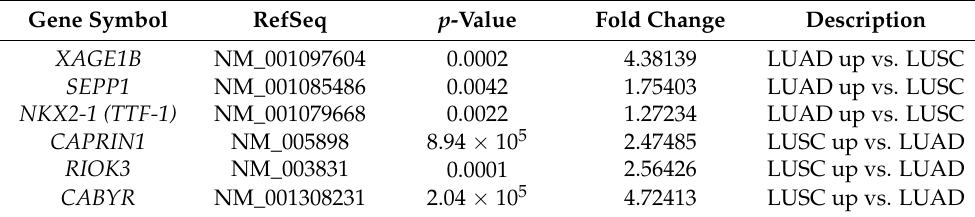
Table 1. Main DEGs for each histology screened using Clariom D assays.